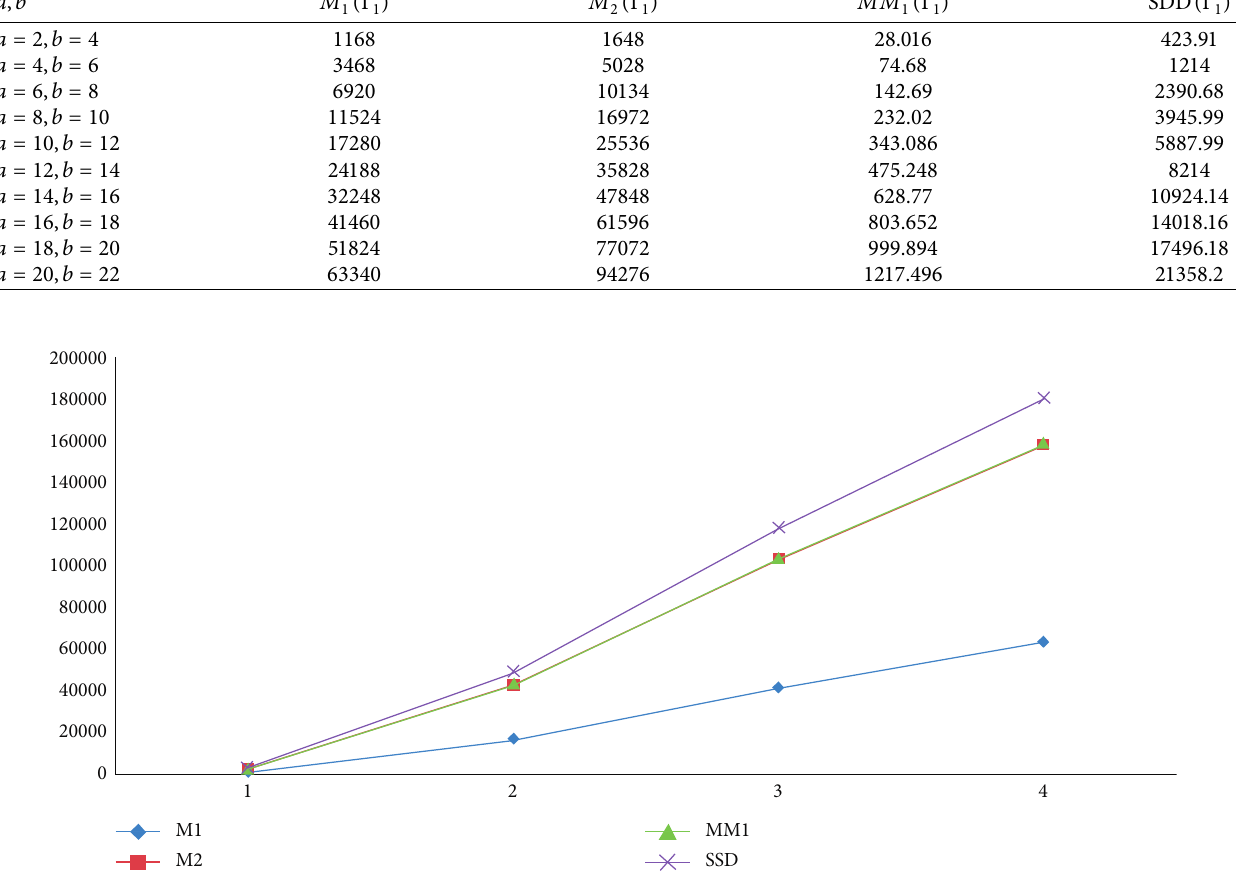
C and comparison between M 5 7 ) of HC 2